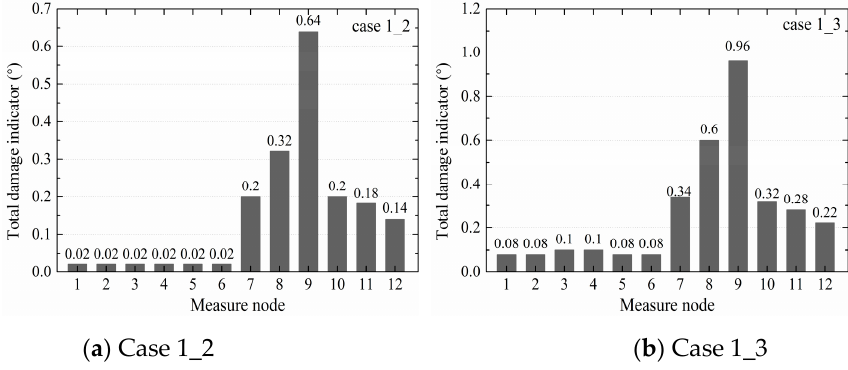
Figure 7. Total damage indicators of cases 1_2 and 1_3 from the SVR models.